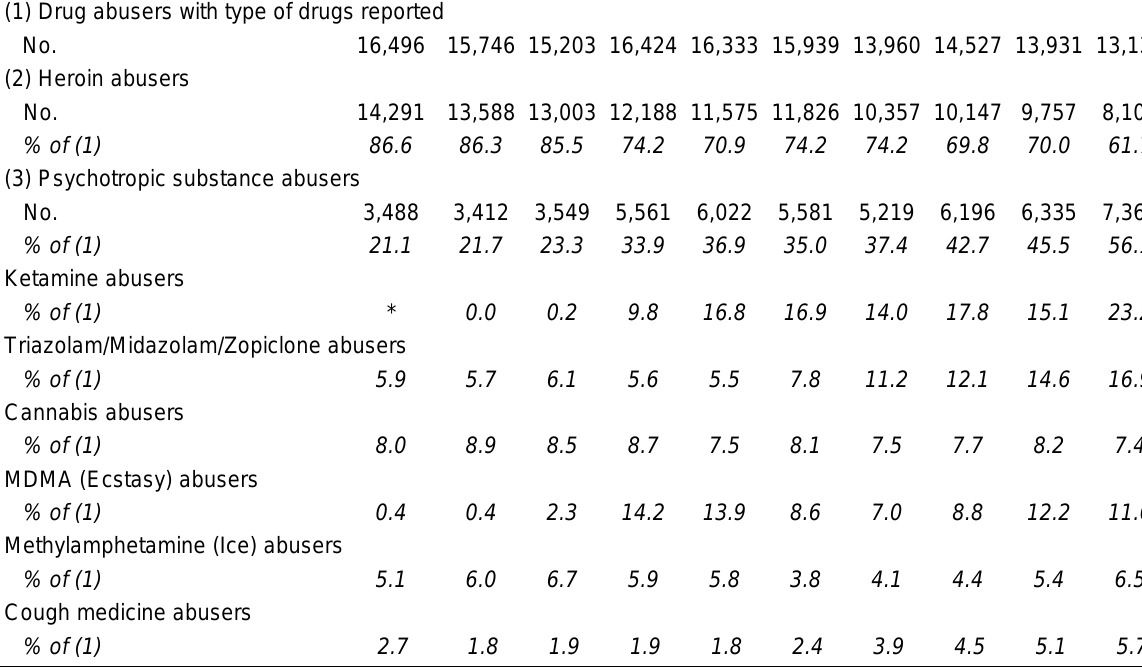
Type of Drug Abused in the Central Registry of Drug